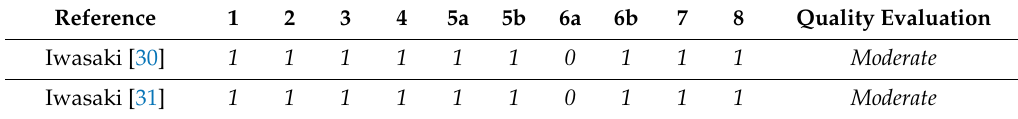
Table 3. The results of the critical appraisal assessments for cohort studies.